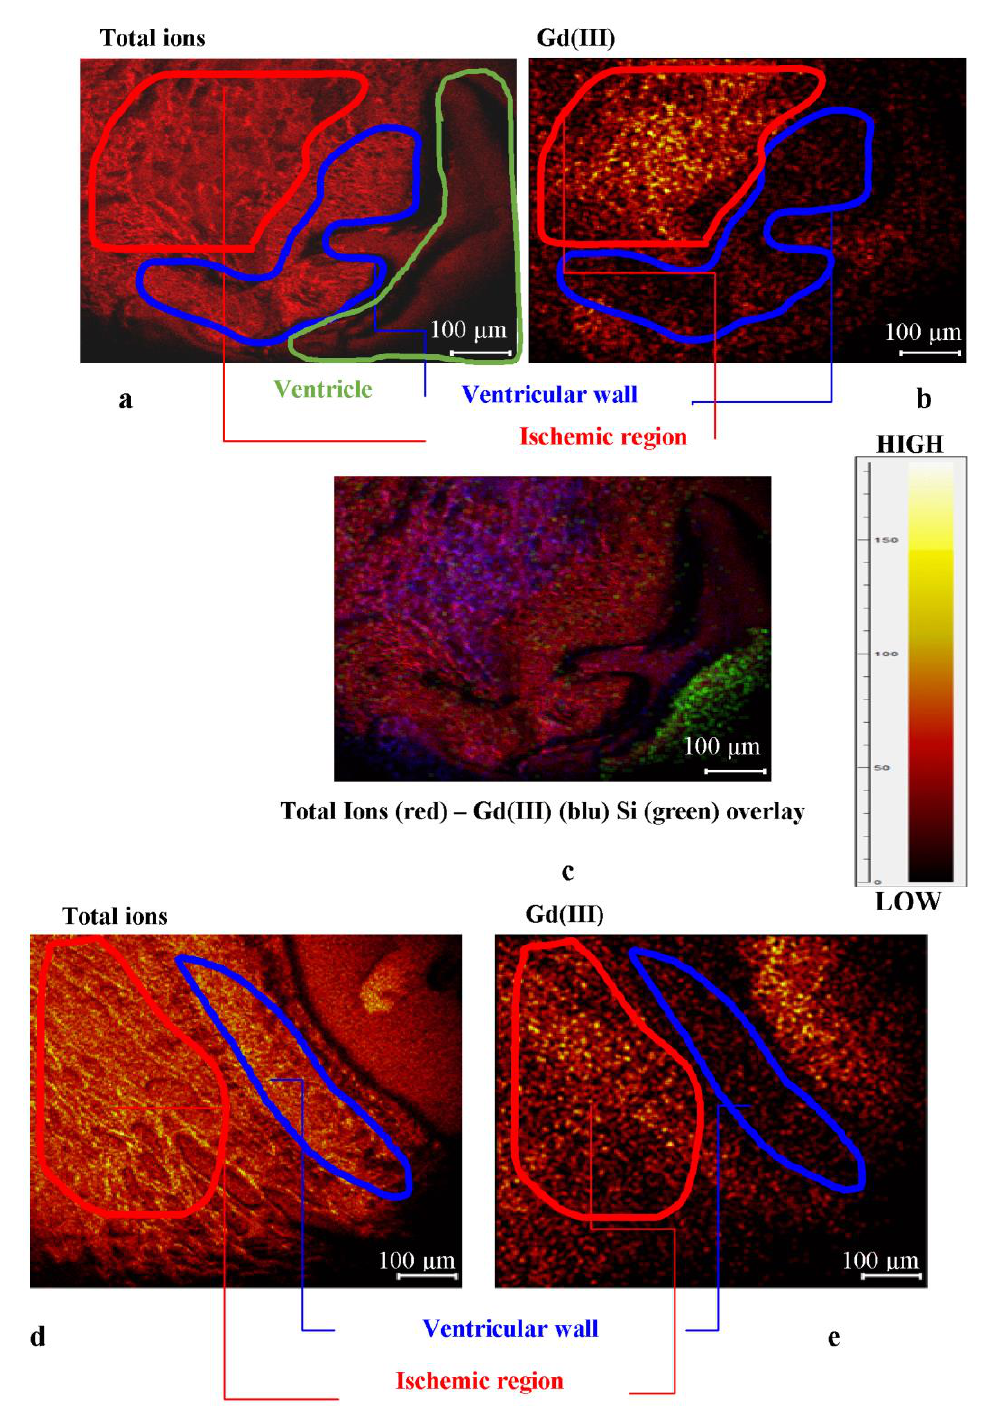
Figure 5. ( a ) Total ions image that highlights three different areas of the sample: Ischemic region (upper left), ventricular wall (middle), and ventricle (lower right); ( b ) distribution map of Gd(III); the image shows accumulation in the ischemic region (upper left); ( c ) ion distribution overlay with Gd (blue) and Si (green); ( d ) total ions image of a different region of the sample; ( e ) Gd(III) distribution map highlighting the accumulation of the tracers in the ischemic region beyond the ventricular wall.